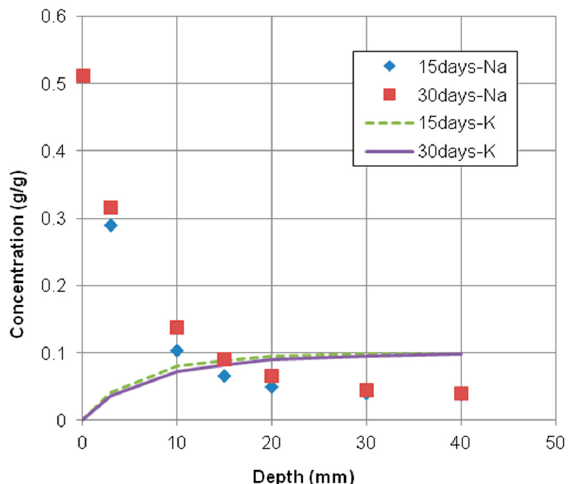
Figure 4. Chloride profiles of concrete specimen with 0.65 water–cement ratio. Exposed for 15 days and 30 days.